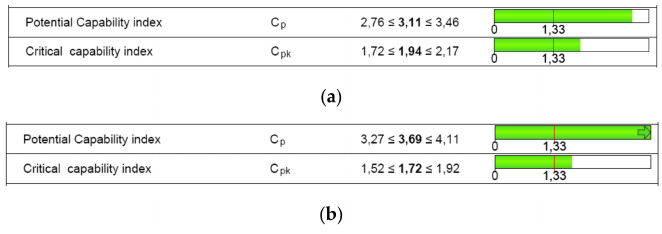
Figure 15. Process capability analysis report based on the capable tolerance of the circular artifact: ( a ) height dimension (H); ( b ) diameter dimension